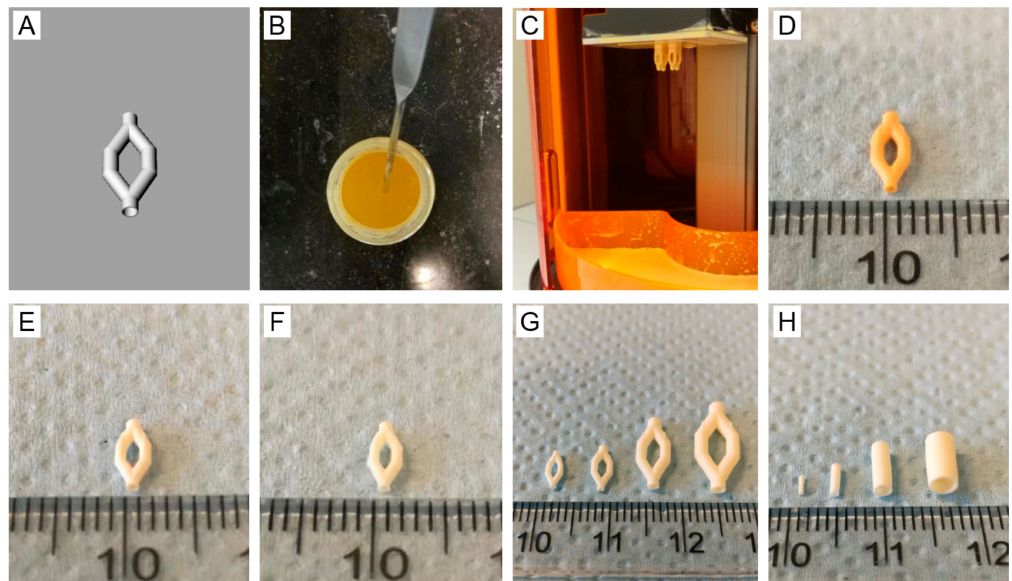
Figure 6. ( A ) design of branched vascular structure; ( B ) PTMC / CaCO 3 composite resin; ( C ) built structures attached to printing head after SLA; ( D ) vascular structure before extraction; ( E ) vascular structure after extraction; ( F ) vascular structure after extraction, postcuring and leaching (hydrated); ( G ) branched vascular structures of di ff erent sizes (extracted, postcured and leached, hydrated); ( H ) vascular tubes of di ff erent sizes (extracted, postcured and leached,